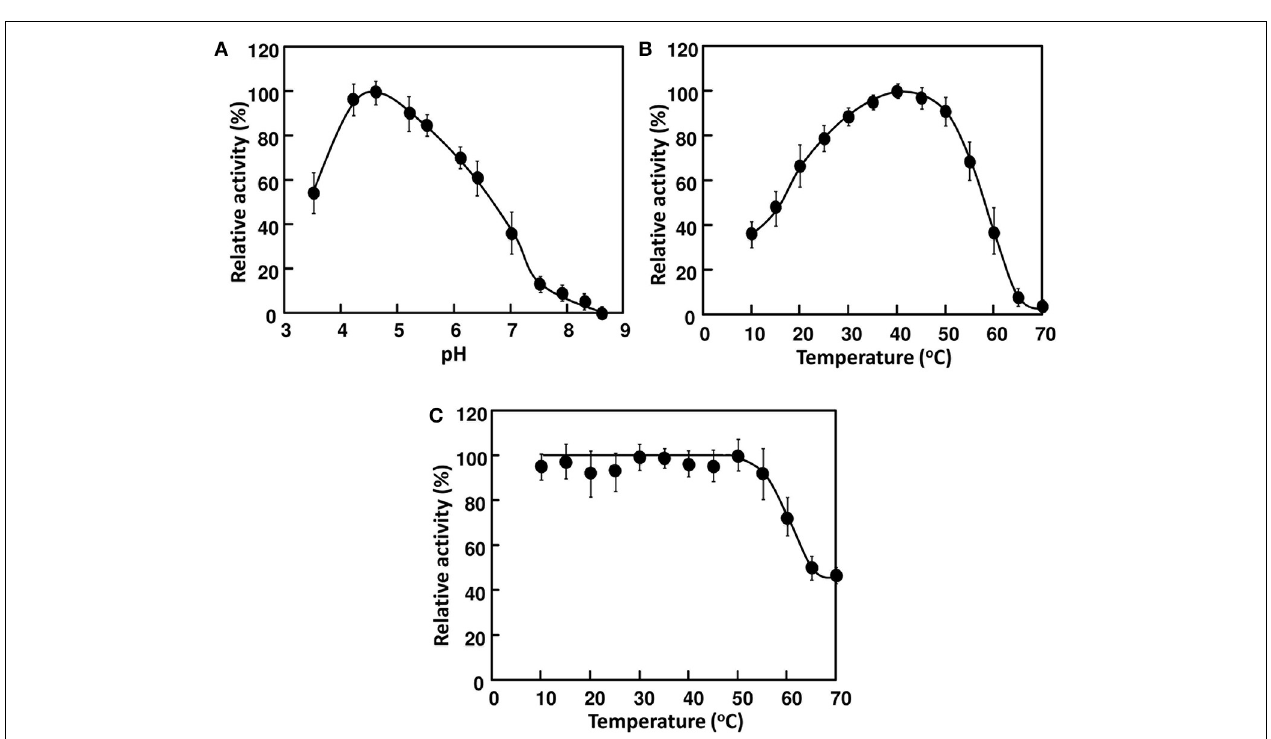
FIGURE 3 | Effects of pH and temperature on the activity of AkEG21. (A) pH dependence of AkEG21 was examined at 30 ◦ C using reaction mixtures adjusted to pH 4–10 with 50mM sodium phosphate buffer. (B) Temperature dependent activity of AkEG21 was measured